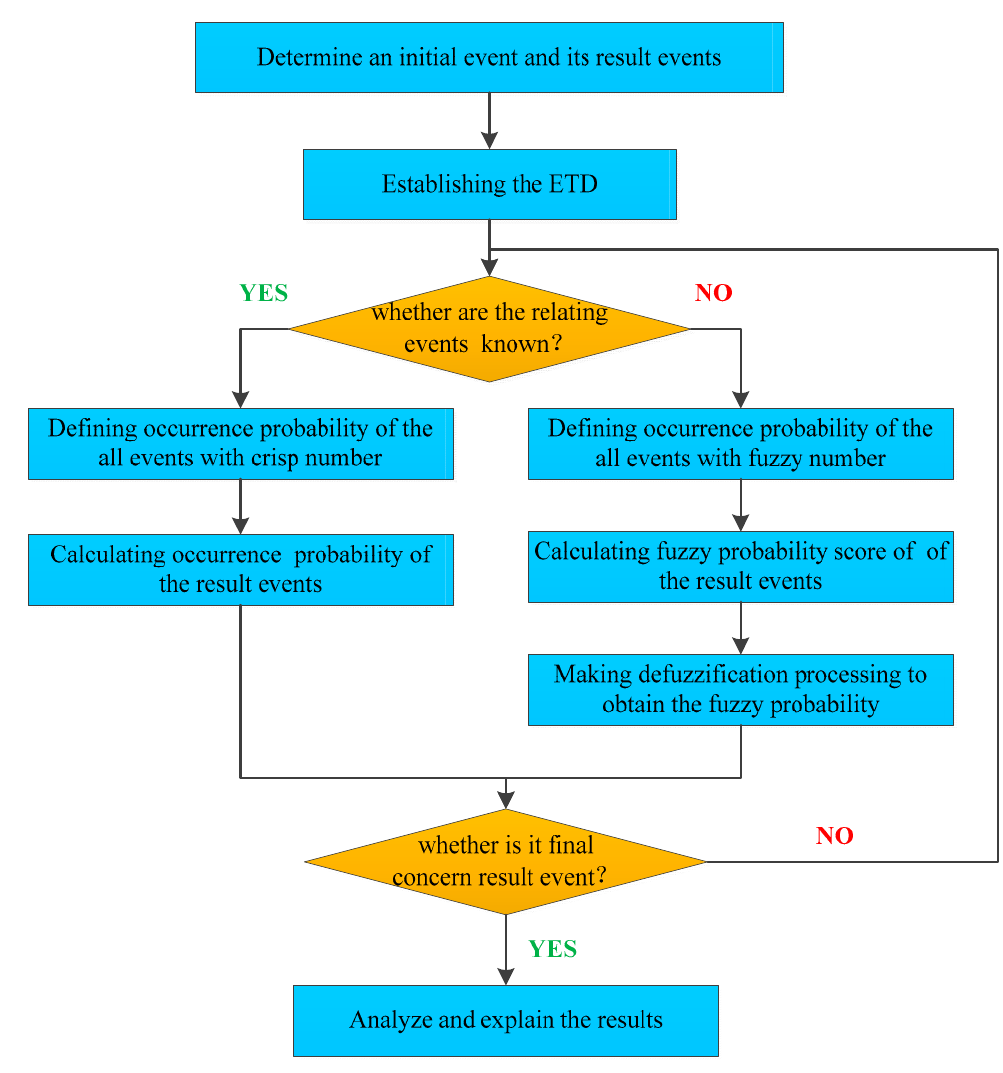
Figure 4. The flow chart of the fuzzy event tree analysis (FETA). ETD: event tree diagram.